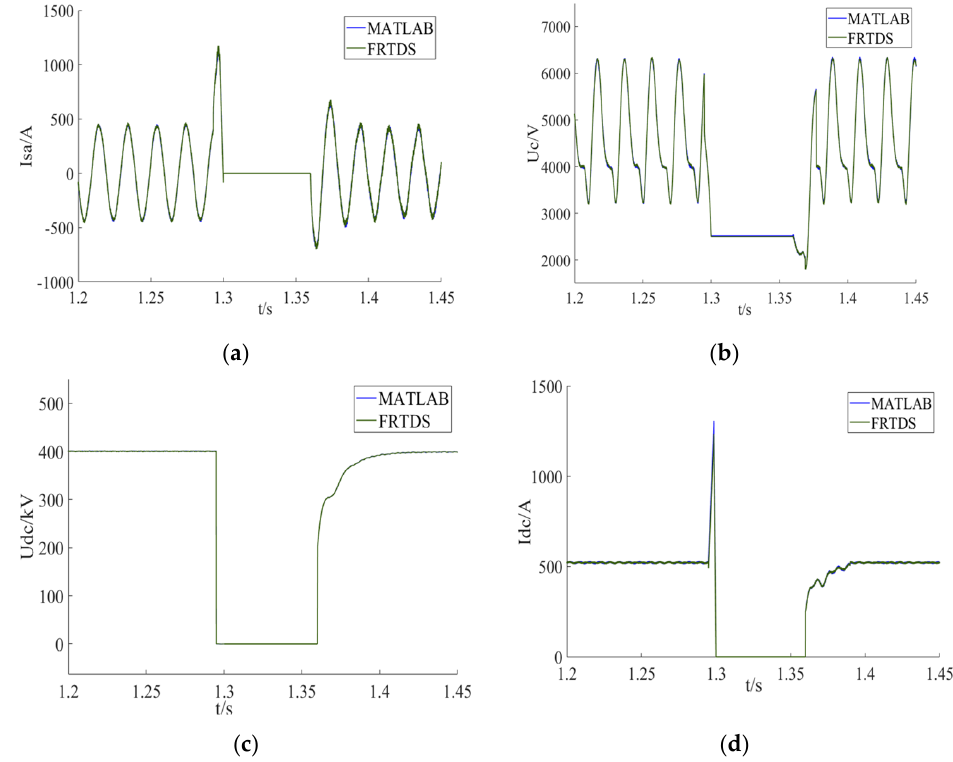
Figure 15. Bipolar fault transient waveform diagram of the MMC simulation system: ( a ) A ‐ phase AC current waveform of the inverter side; ( b ) waveform diagram of the capacitor voltage of the upper bridge arm of phase A on the rectifier side; ( c ) DC ‐ side voltage waveform; ( d ) DC ‐ side current waveform.